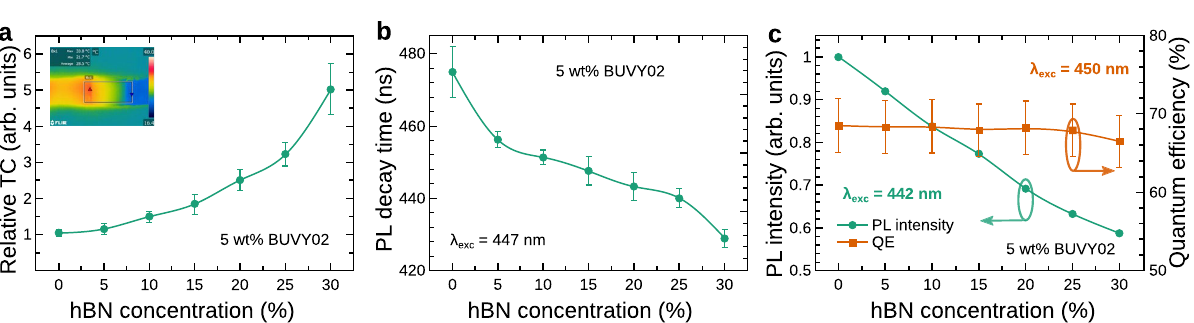
Figure 2. Thermal and PL properties of the phosphor-silicone converter containing 5 wt% BUVY02 phosphor for different hBN concentrations. ( a ) The relative TC of the converter. The inset shows the temperature gradient between the sample and reference recorded during the TC measurements. ( b ) The PL decay time of the converter (measured under 447 nm LED excitation). ( c ) The integrated PL intensity (green circles) and the quantum efficiency (orange squares) of the converter. The PL intensity was measured under 442 nm LD excitation; the PL quantum efficiency was measured under 450 nm